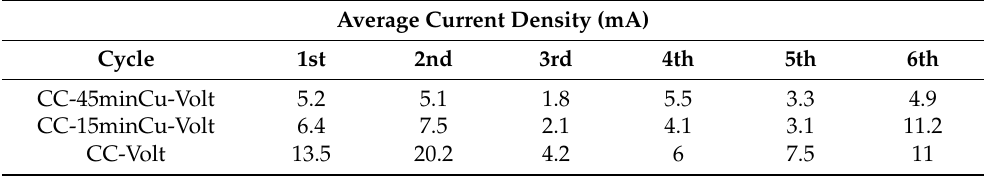
Figure 8. Variation in VFAs composition (mg L − 1 ) over time in the different serum bottles for the ( a ) Control, ( b ) CC-Volts, ( c ) CC-Cu15mins-Volts and ( d ) CC-Cu45mins-Volts; blue represents the acetic acid and green the propionic acid. Table 3. Average current density for serum bottles CC-volts, CC15min-volts and CC45minCu-volts over the 6